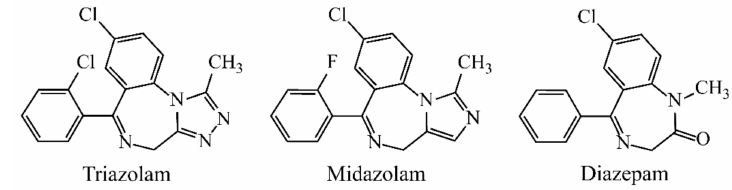
Figure 1. Chemical structures of three